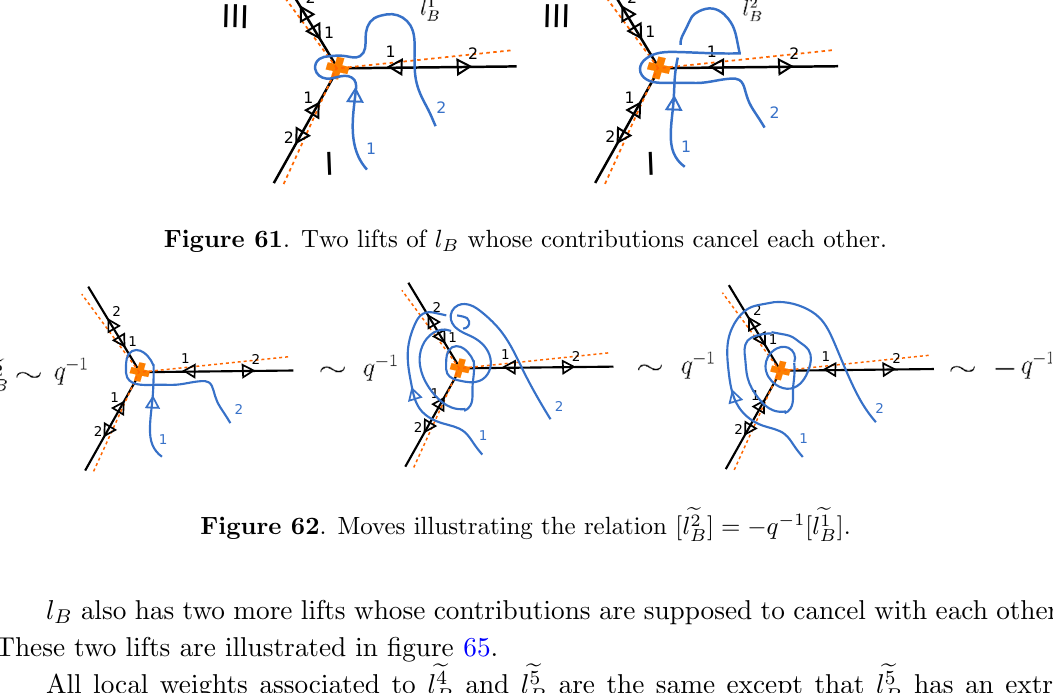
Figure 62 . Moves illustrating the relation [ e l 2